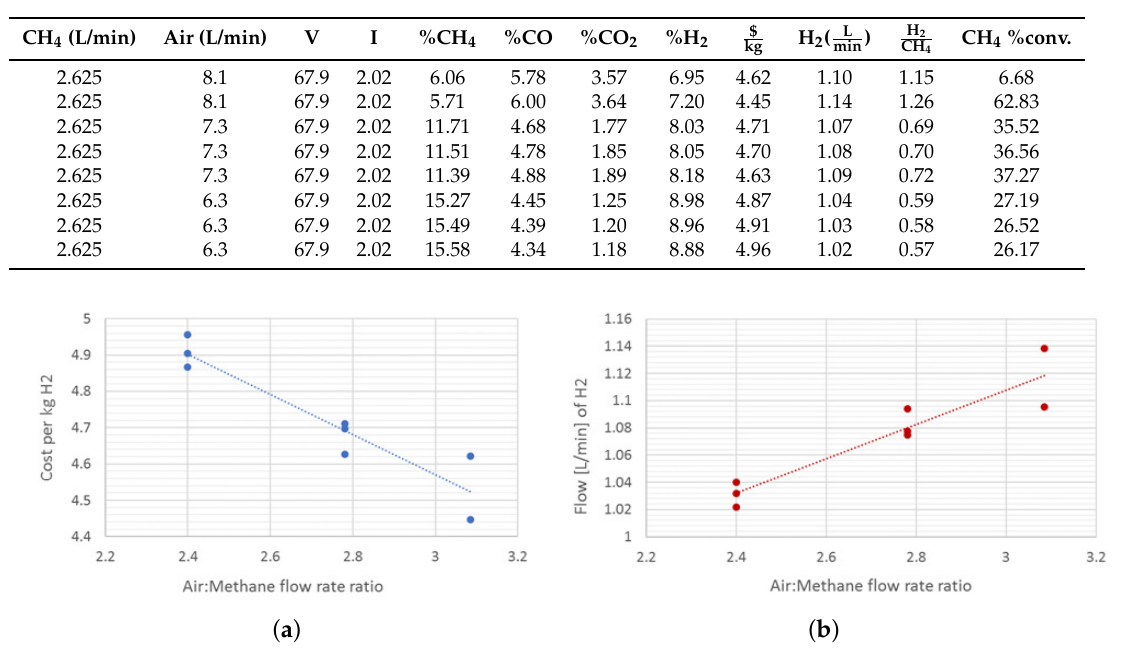
Table 3. Results of experimental modeling, where price per ccf of methane psia = $0.366 and price per kWh of electricity = $0.09.